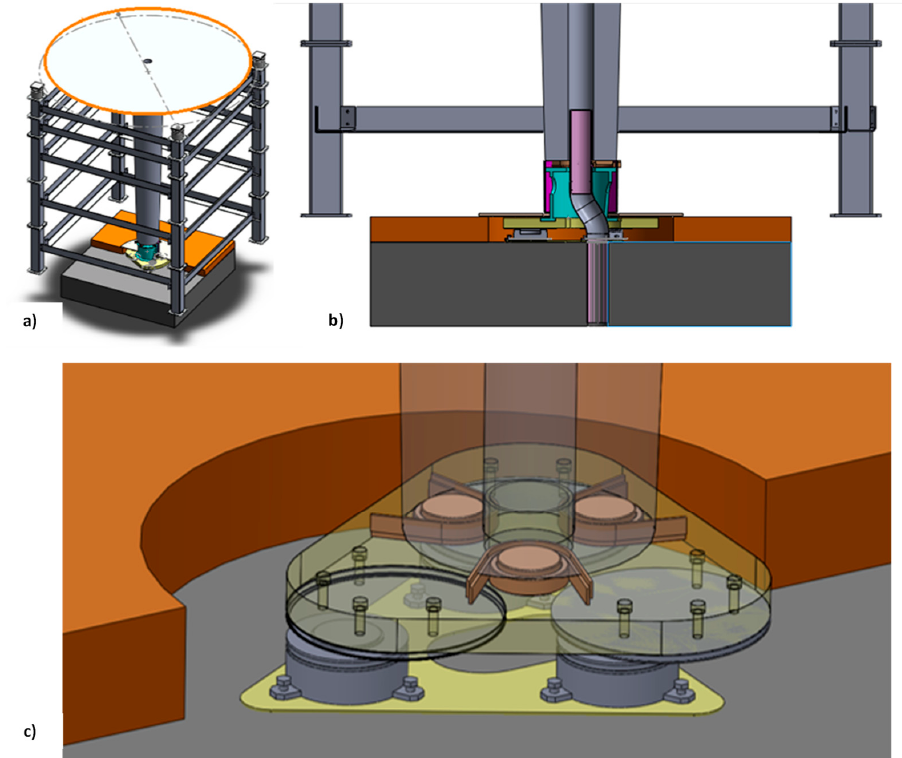
Figure 16. Technical drawings of the tripod, made during their design (all dimensions in mm).